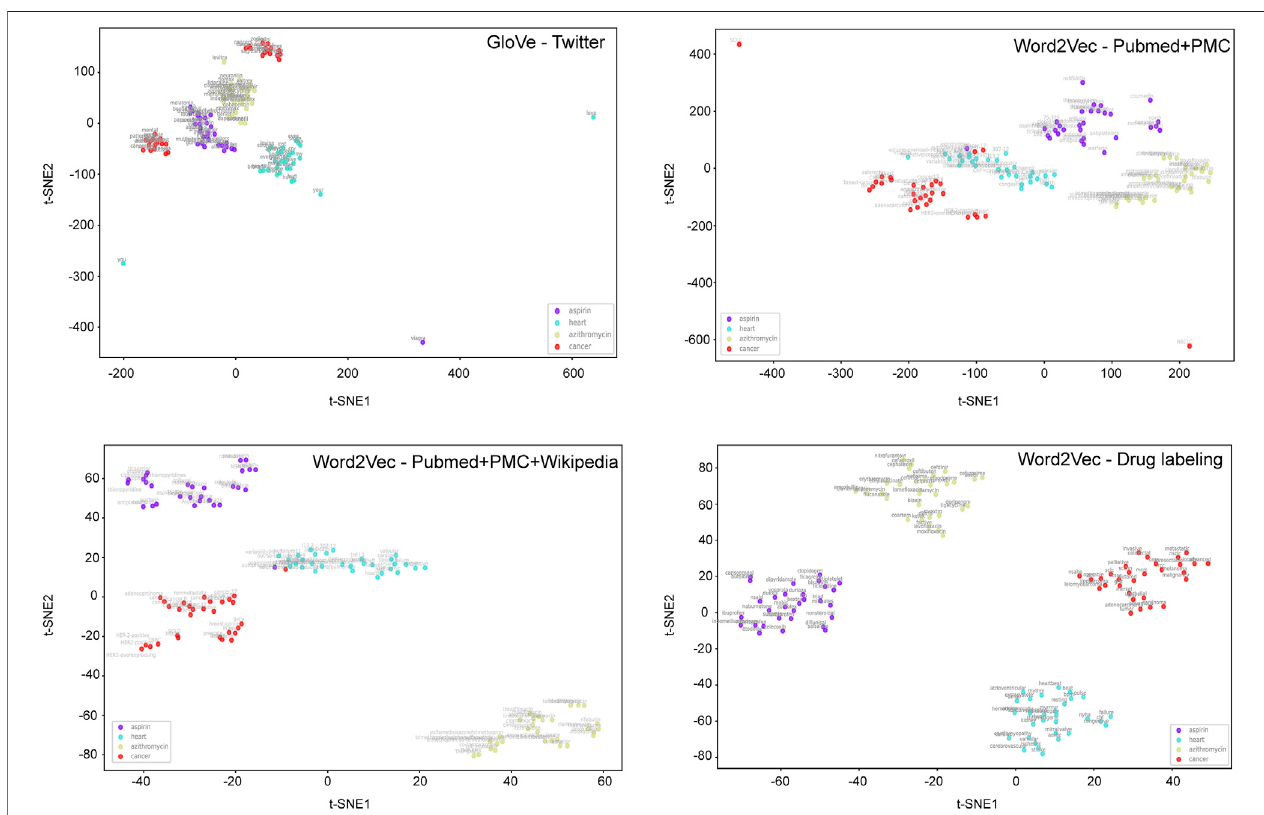
FIGURE 3 | t-SNE analysis of different word embedding models on the queried words.